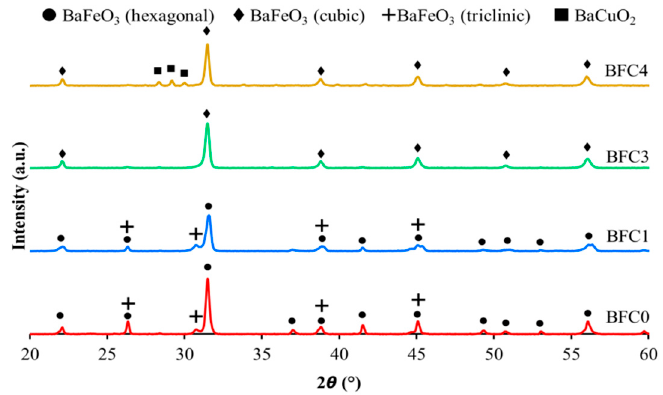
Figure 1. XRD patterns for fresh BaFe 1 − x Cu x O 3 catalysts.